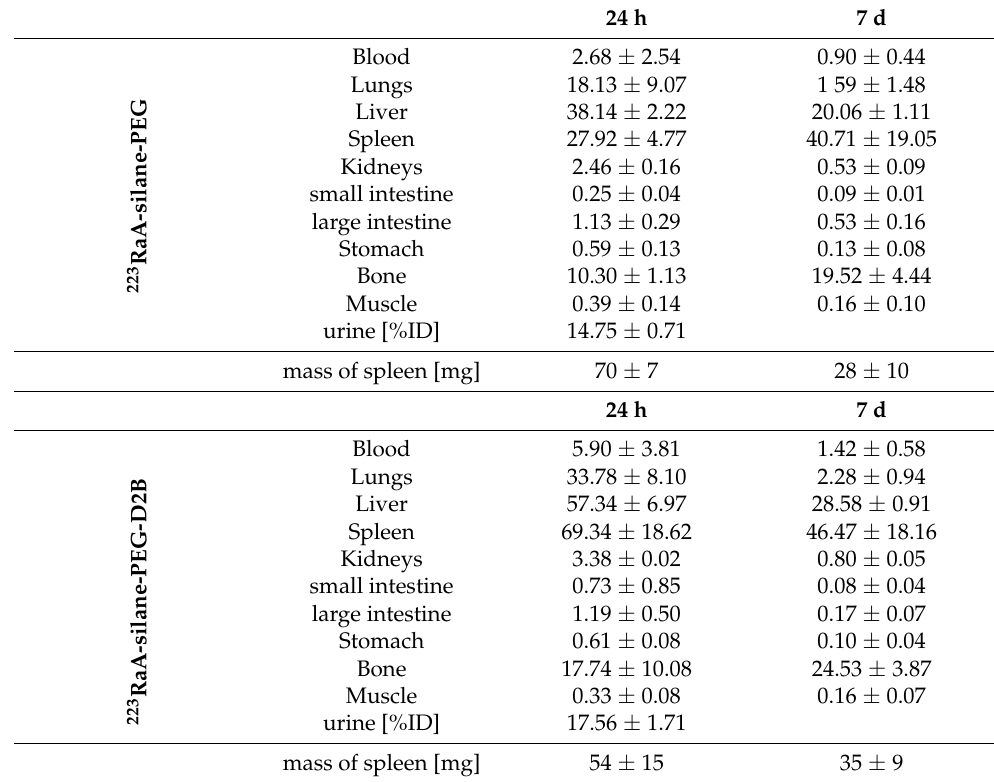
Table 2. Biodistribution of 223 RaA-silane-PEG and 223 RaA-silane-PEG-D2B in BALB/c mice. Values are expressed as %ID g − 1 and presented as mean ± standard